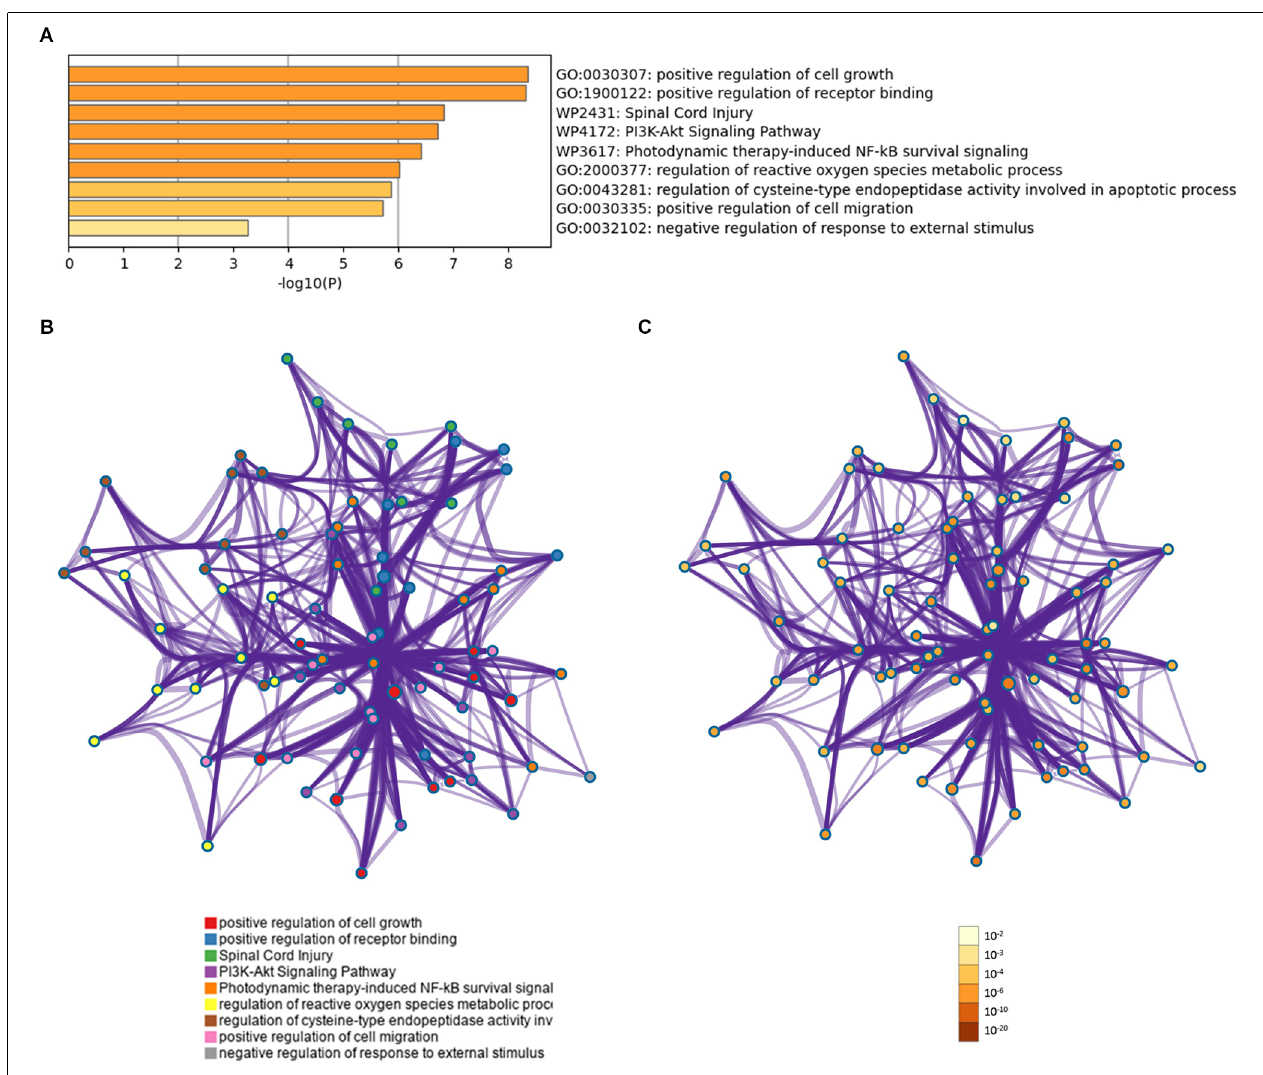
FIGURE 4 | Functional profiling of the identified proteins. (A) Shown are significantly enriched gene ontology (GO) and Kyoto Encyclopedia of Genes and Genomes (KEGG) terms. (B) Protein-protein interaction network of GO and KEGG enriched terms colored according to clusters. (C) Protein-protein interaction network of GO and KEGG enriched terms colored according to P